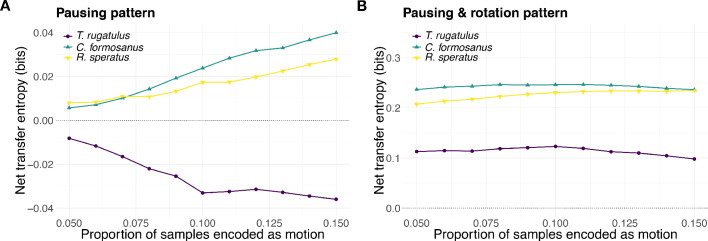
Perturbation analysis of pause-motion threshold.Net transfer entropy as a function of the probability threshold used to encode step sizes into the motion state and pausing state. (A) Results for the pausing pattern. (B) Results for the compound pausing and rotation pattern. Sampling period and history length correspond to those in Table 1. Positive values represent information transfer from leader to follower, negative values represent information transfer from follower to leader.